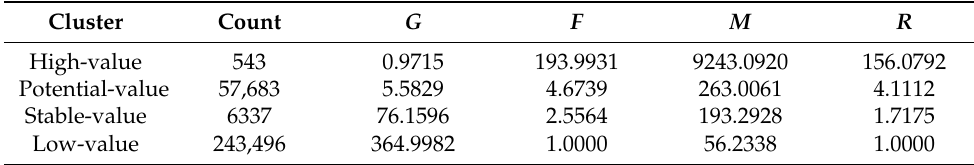
Table 2. Clustering customer by GFMR